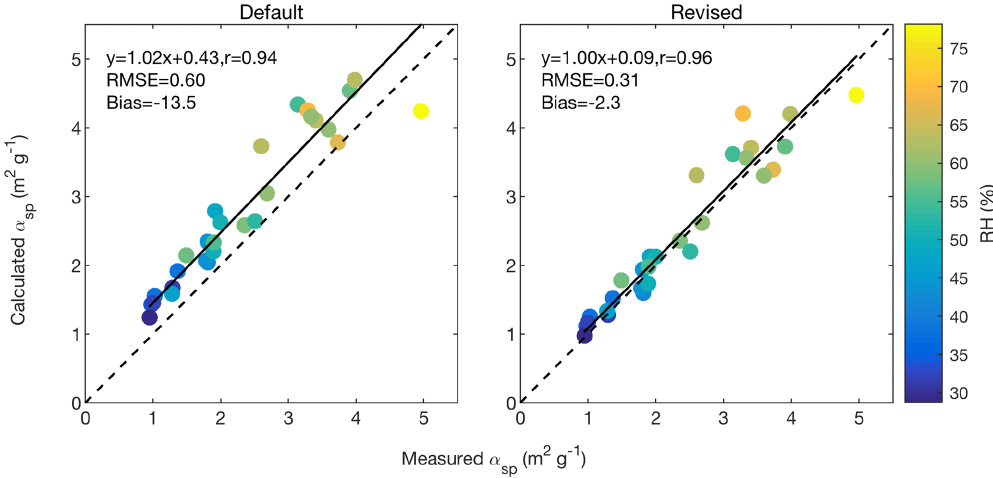
Figure 2. Average measured vs. calculated α sp at 550nm at IMPROVE sites between 2000 and 2010 using GEOS-Chem default optical tables and revised optical tables. The colour of each point corresponds to the average relative humidity at the site. The 1 : 1 line is black. Slope, offset, and correlation coefficient are inset.